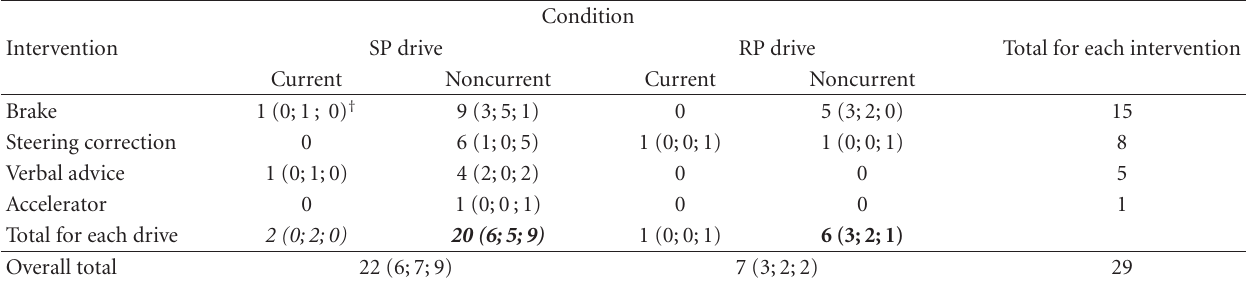
Table 2: Summary of interventions that occurred in each condition and on each side for current ( n = 4) and noncurrent ( n = 8) drivers.